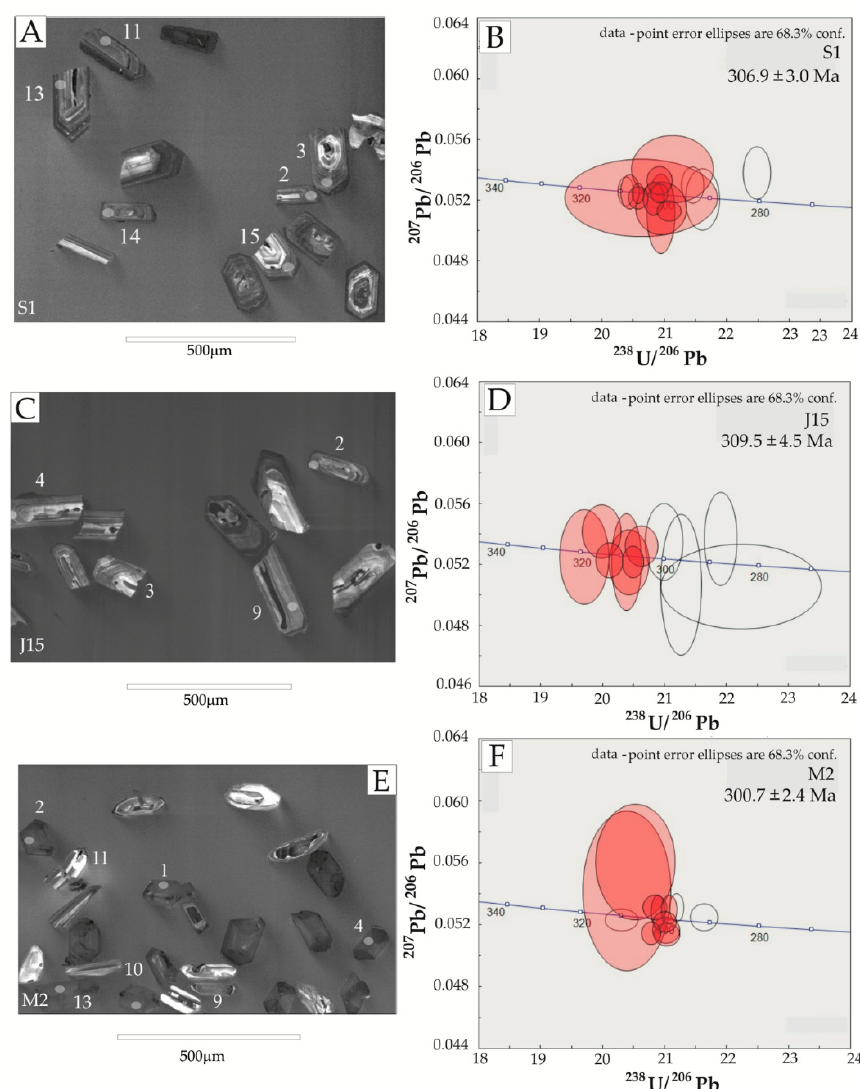
Figure 11. Cathodoluminescence images of selected zircon grains (ellipses show analysis locations) and concordia diagrams showing SHRIMP zircon U-Pb analyses (open symbols–analyses not included in the age calculations) of igneous rocks from the area of the KP and its eastern metamorphic cover. ( A , B ) equigranular granite, Sample S1, from the Szklarska Por˛eba Huta granite quarry; ( C , D ) equigranular granite, Sample J15, from the area of the Miedzianka deposit; ( E , F ) rhyolite porphyry, Sample M2, from the Miedzianka Cu(-U)